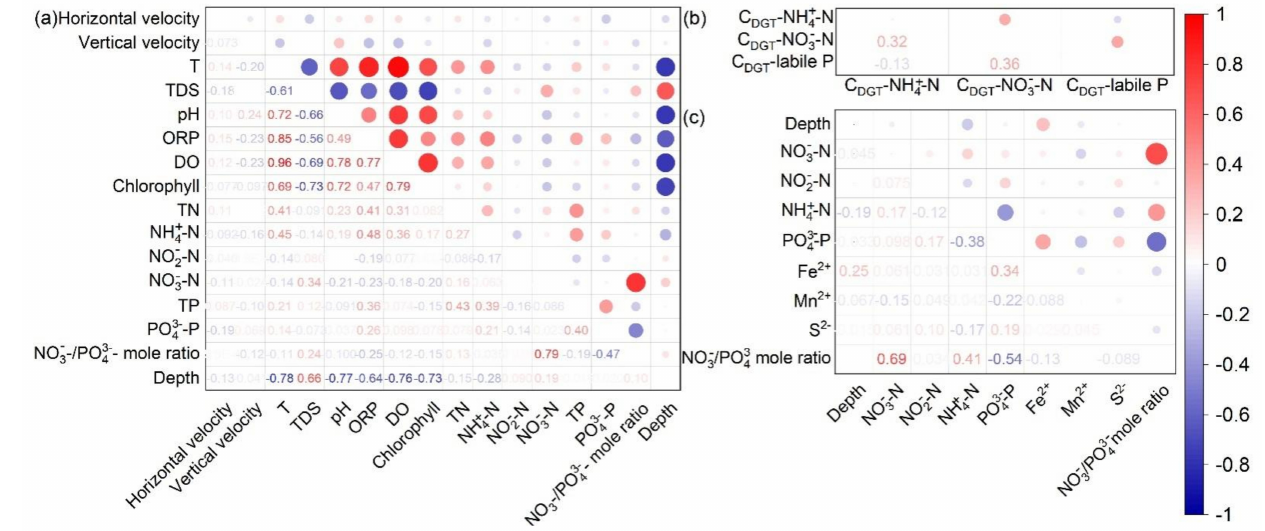
Figure 6. Correlation analysis among N, P, and other indexes of surface water (( a ), n = 104), overlying water (( b ), n = 50), and pore water (( c ), n = 212) in Hongfeng Lake in